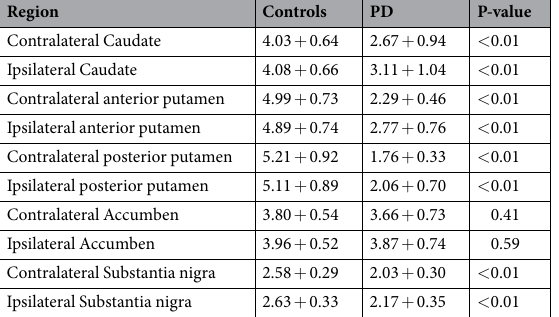
Table 3. Regional intensity differences between controls and patients with PD in the late phase 18 F-( + )DTBZ